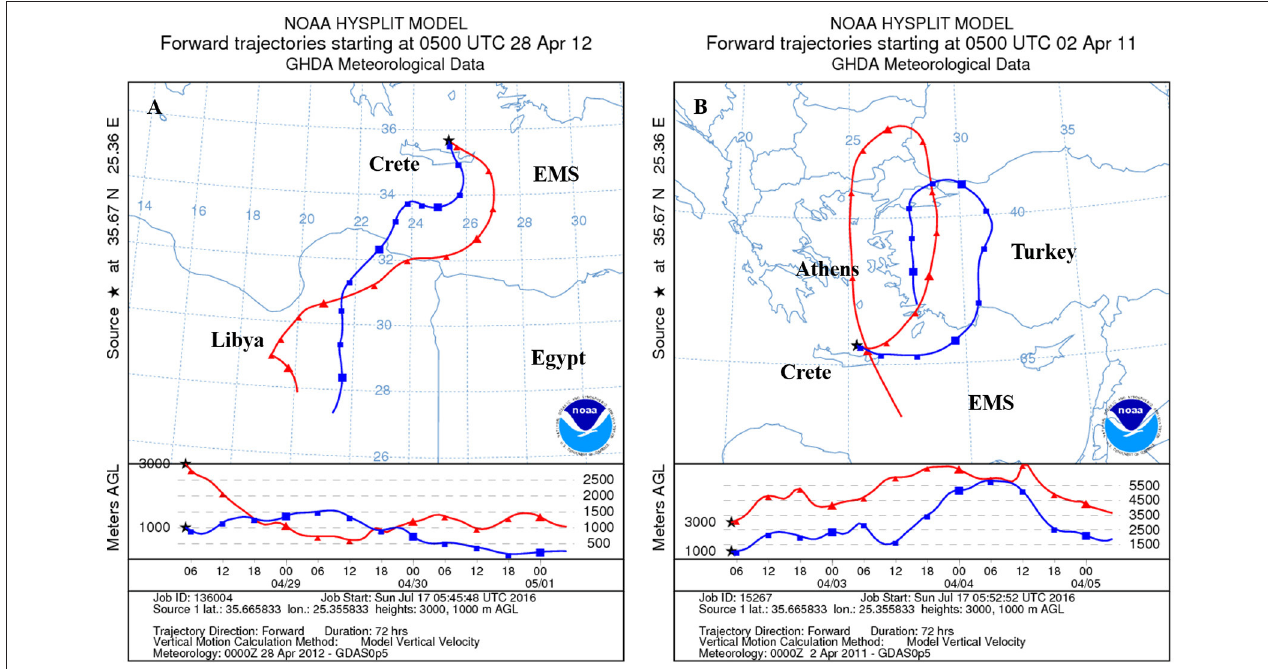
FIGURE 2 | Representative air mass back trajectories derived from the backward trajectories model NOAA/ARL HYSPLIT-4 (www.noaa.gov), showing the origin and track of the Saharan-dominated population (A) and the anthropogenic-dominated population (B) over the 3 days that preceded their collection at Crete and